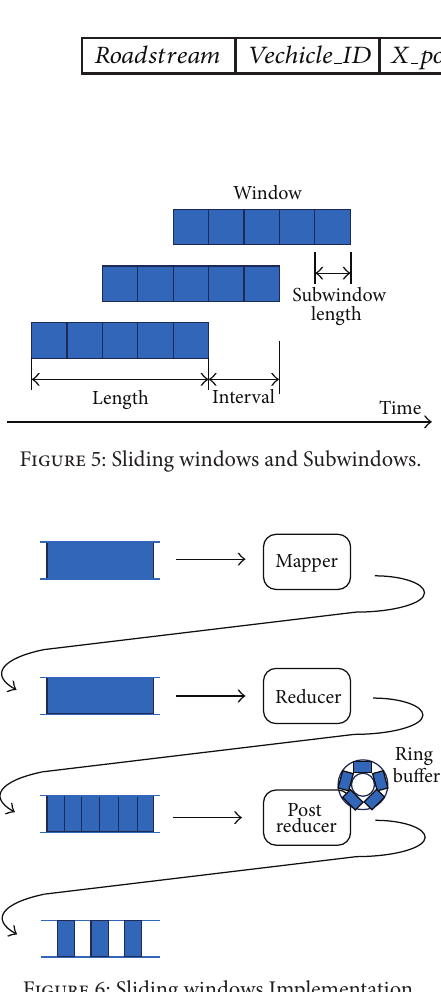
Figure 6: Sliding windows